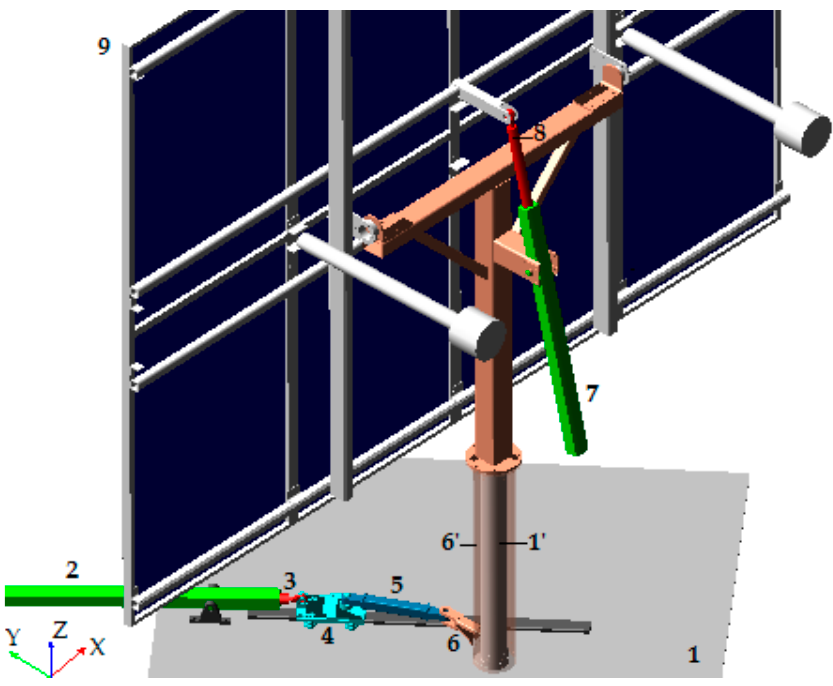
Figure 4. MBS model of the proposed bi-axial solar tracker (ADAMS).